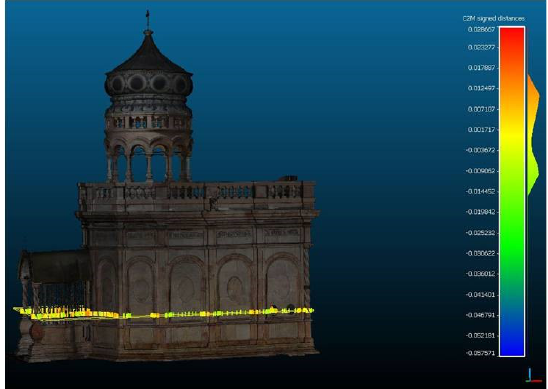
Figure 11 . The 2 nd horizontal section and its deviations from the reference surface